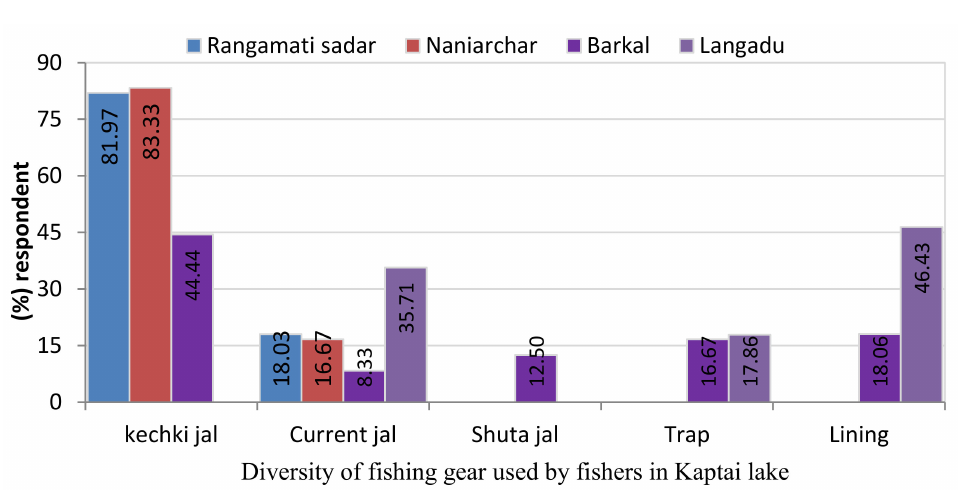
Figure 6. Status of fishing gear used by the fishers in the different study areas of Kaptai